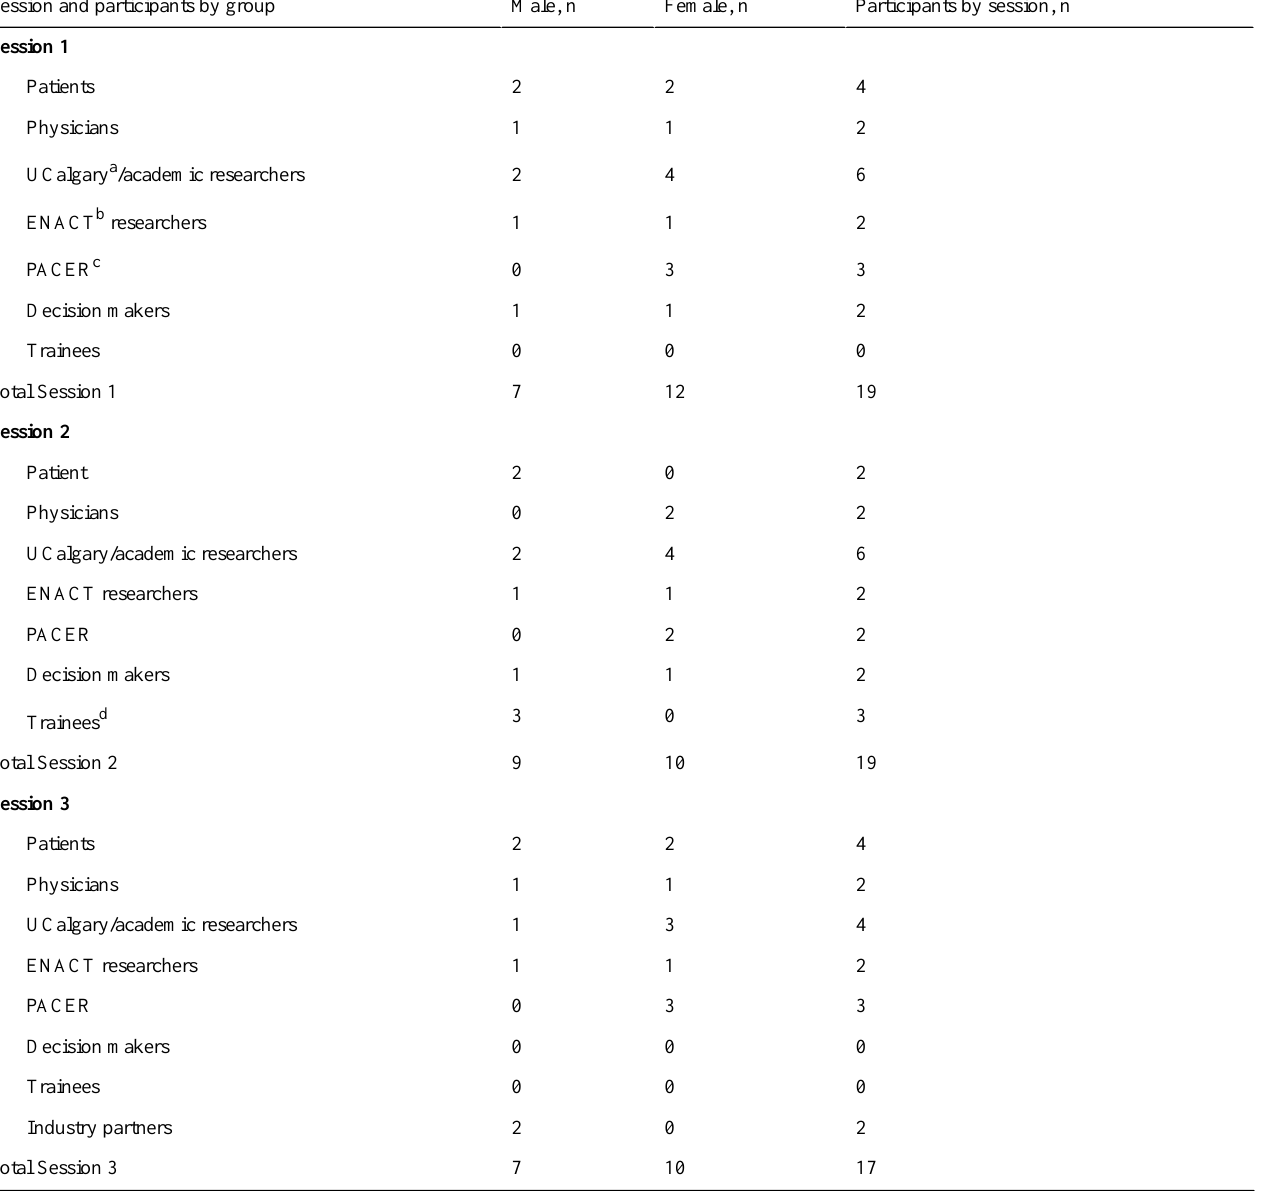
Table 2. Co-design participant demographics (sessions